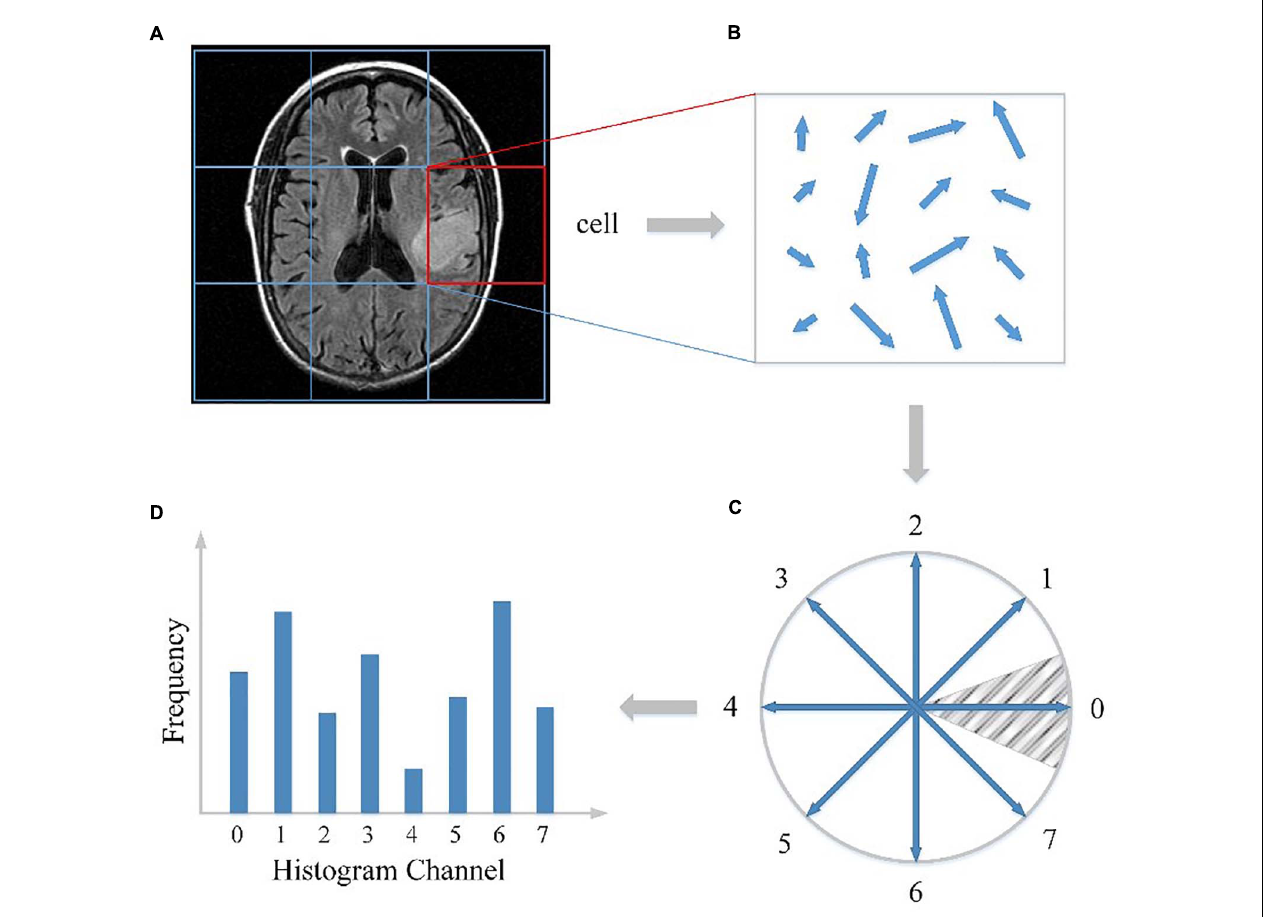
FIGURE 1 | HOG feature extracted from the MRI image. (A) The MRI image divided into cells. (B) The gradient calculation result of one cell. (C) The partition scheme including 8 channels. (D) The cell histogram generated by counting the weighted number of pixels distributed in different direction channels.